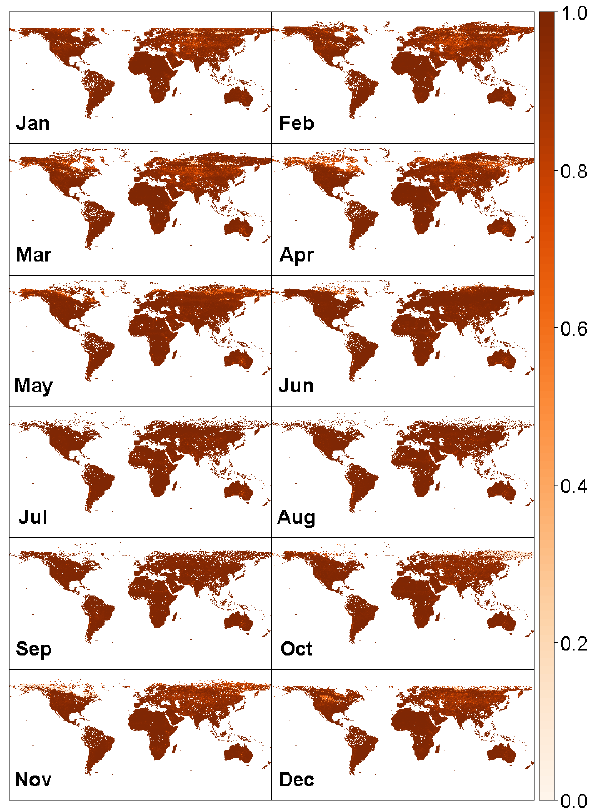
Figure 6. The slope (intercept = 0) determined from linear regre- sion on a per-pixel basis for the Vegetation Index and Phenology Lab version 3 normalized difference vegetation index vs. the Global Inventory Modeling and Mapping Studies normalized difference vegetation index version 3. Slope was determined using a 30-year time series of 15-day composites for each month. The images have been masked for significance ≤ 0.05 and latitudes ranging from 60 ◦ N–60 ◦